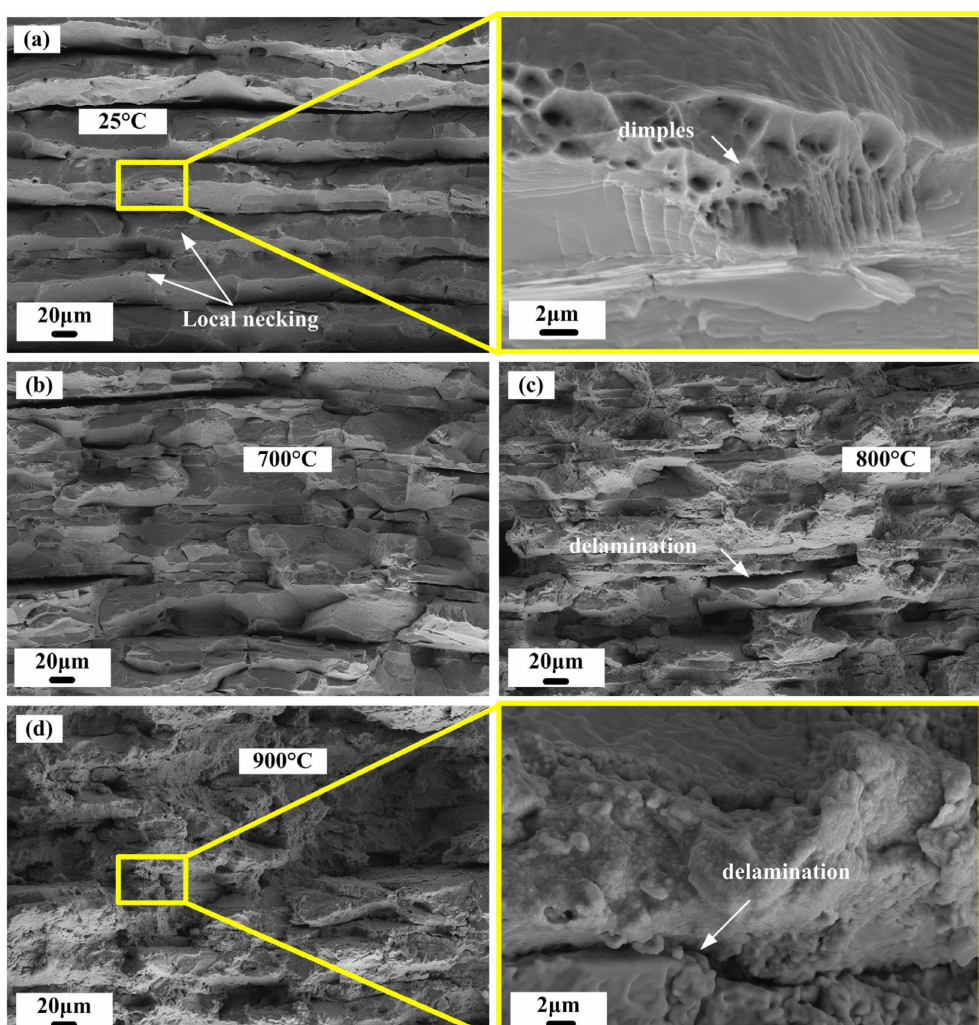
Figure 9. Fracture morphology of the tensile specimens at ( a ) 25 ◦ C; ( b ) 700 ◦ C; ( c ) 800 ◦ C; ( d ) 900 ◦